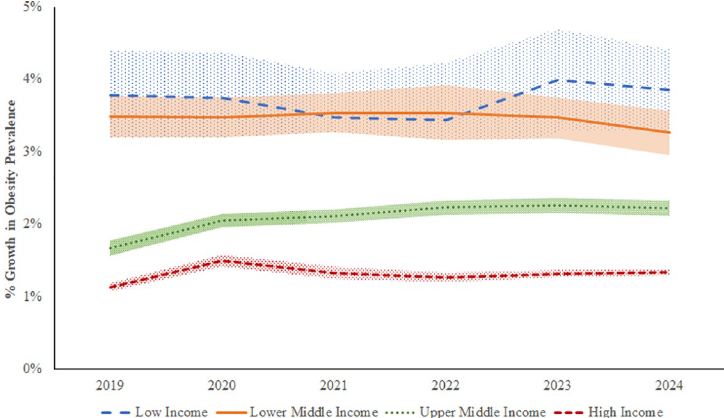
Fig 4. Forecasted percentage growth in adult obesity prevalence for countries grouped by national